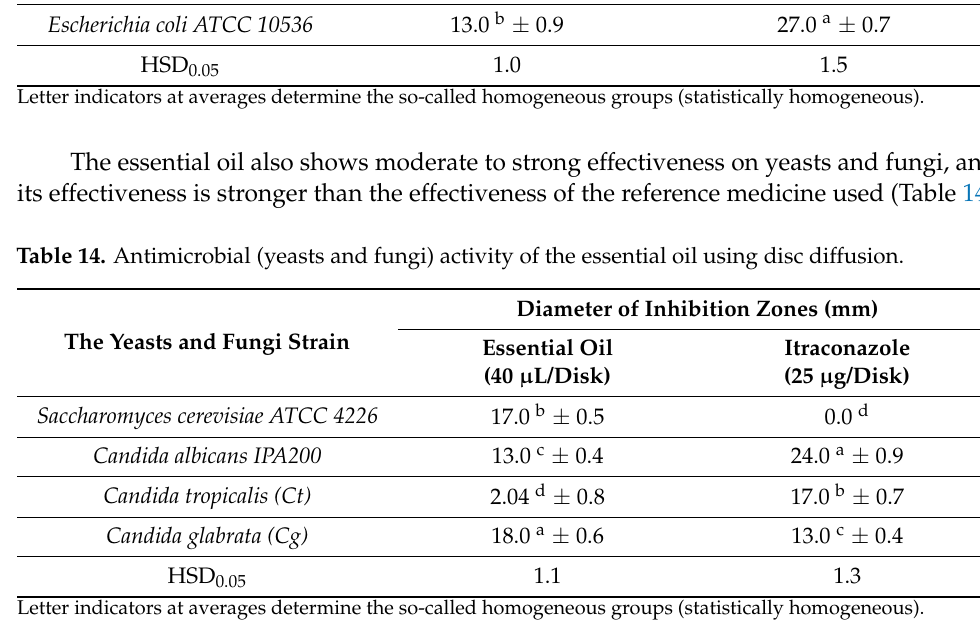
The Bacteria Strain